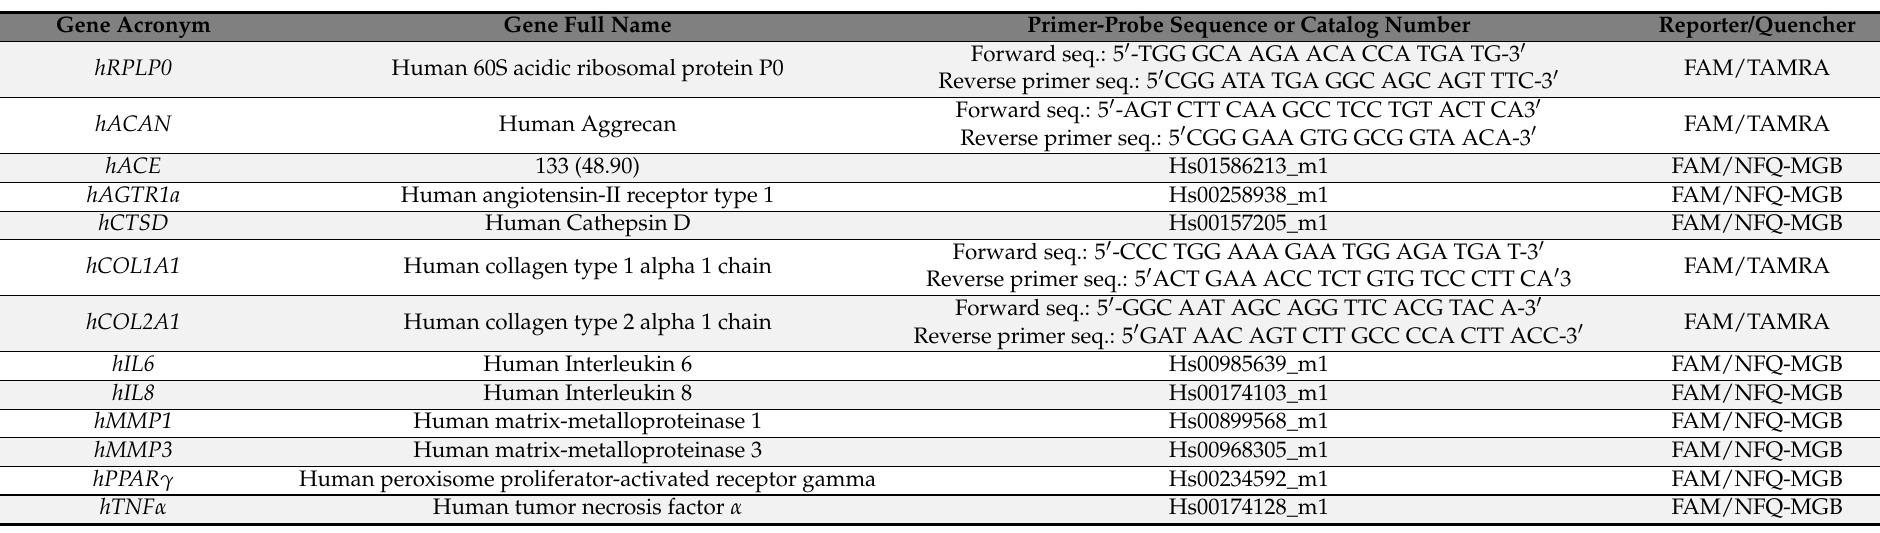
Table 1. Characteristics of custom-designed primer-probes and gene expression assays (Applied Biosystems) used for gene expression